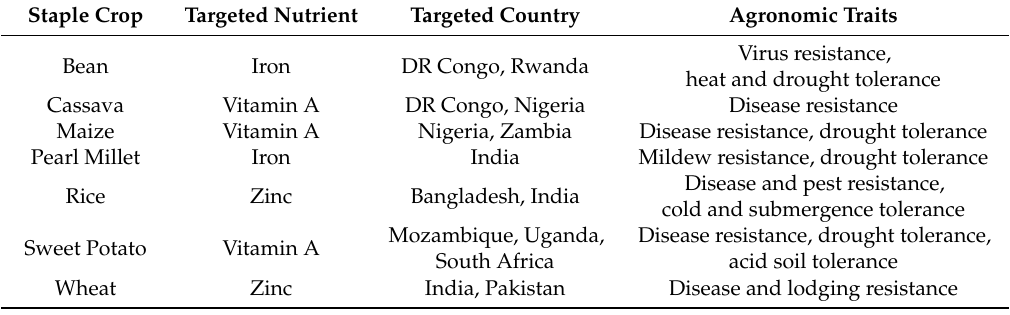
Different biofortified staple crops in different countries with their agronomic and micronutrient